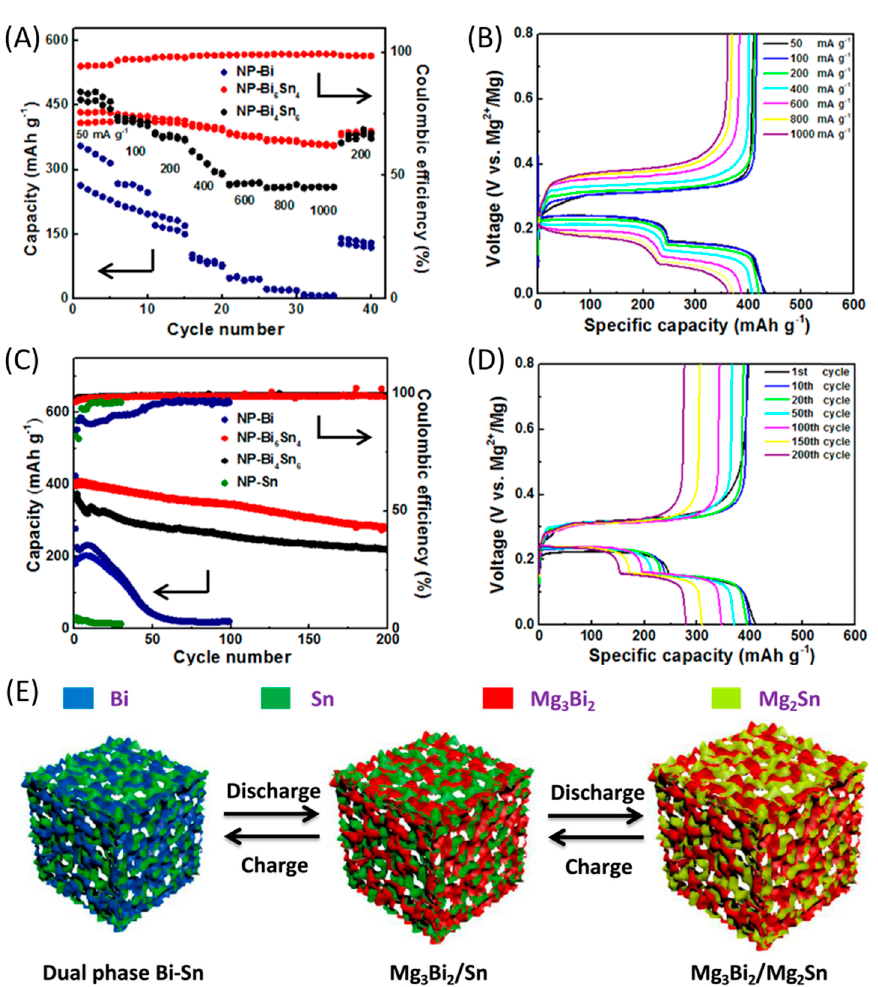
Figure 11. ( A ) Rate performance for NP-bismuth and alloy electrodes; ( B ) Discharge/charge profiles for NP-Bi 6 Sn 4 electrode at different current densities; ( C ) Cycling stability of NP-bismuth and alloy electrode at 200 mA g –1 and of NP-tin at 20 mA g –1 ; ( D ) Discharge/charge profiles of NP-Bi 6 Sn 4 electrode for different cycles at 200 mA g –1 ; ( E ) Schematic illustration of the electrochemical reaction mechanisms of alloy electrodes. Adapted with permission from [170]. Copyright Elsevier B.V.,